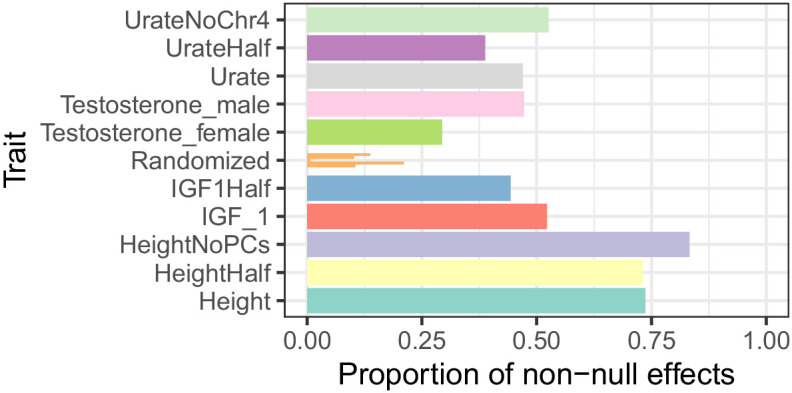
Proportion of non-null associations in a random sample of 100,000 variants for each trait.Variants are then filtered to those with minor allele frequency greater than 5%, and ashR is run on the beta and standard error to estimate the proportion of non-null associations. ‘‘UrateNoChr4’’ is the Urate GWAS with chromosome 4 excluded, where the two largest effect loci, SLC2A9 and ABCG2, are both located. Traits with the suffix ‘Half’ are 50% downsamplings of the White British cohort to approximate the sample sizes of the sex-stratified testosterone GWAS. ‘Randomized’ are random associations generated by evaluating shuffled versions of the Urate (n = 3 shuffles) and IGF-1 (n = 3 shuffles) phenotypes and represent estimates we might expect under the null distribution of no associations, where we observe some noise but consistently observe estimates well below that of un-shuffled traits. These global estimates represent the proportion of all variants in a given trait that are linked to causal sites.